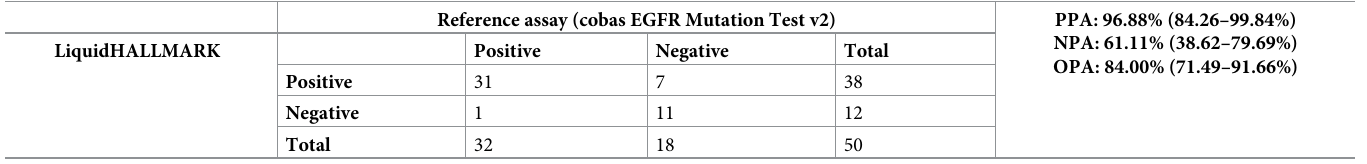
Table 3. Comparison of LiquidHALLMARK with cobas EGFR Mutation Test v2 for the detection of EGFR L858R, exon 19 deletion, T790M, and G719X/S768I/ exon 20 insertion variants.